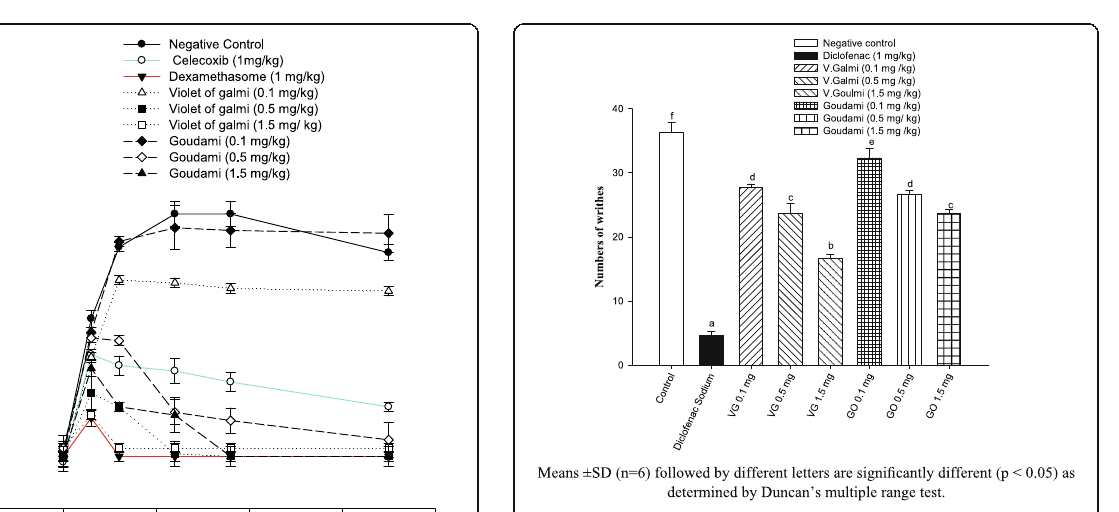
Fig. 2 Effect of variety and concentration of aqueous extracts of onion on acetic acid induced writhes in albinos mice. Means ±SD ( n =6) followed by different letters are significantly different ( p <0.05) as determined by Duncan ’ s multiple range test